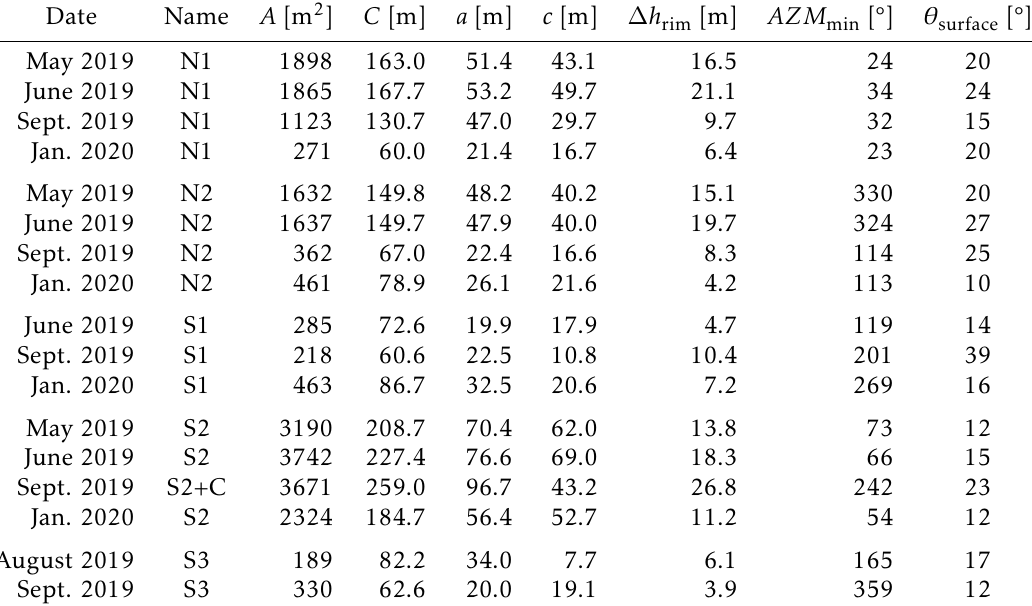
Table 1: Geometrical parameters of N1, N2, S1, S2, and S3 craters from May 2019 to January 2020 detailing area ( A ), circumference ( C ), long axis ( a ), short axis ( c ), the vertical difference between highest and lowest point of the crater rim ( Δ h rim ), the azimuth of the lowest point of the crater rim ( AZM min ) and the dip angle of the theoretical surface plane between highest and lowest point of the crater rim ( θ surface